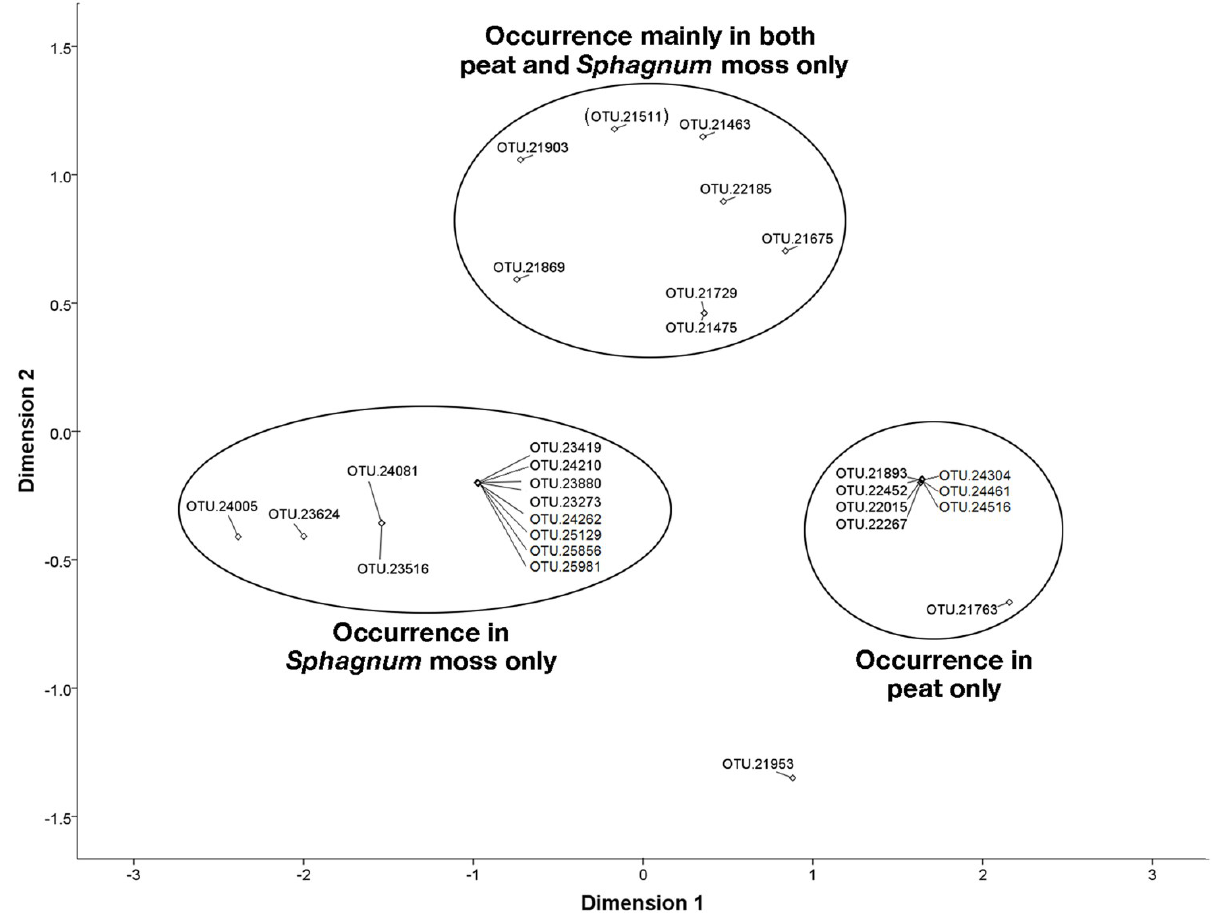
Figure 6. Similarity in the presence and abundance of the Methylococcaceae detected in peat, forest soil, and Sphagnum moss as a two-dimensional plot of nonmetric multidimensional scaling (NMDS; Stress = 0.07667, R 2 = 0.97896). OTUs on the NMDS plot that are closer to one another are more similar in their occurrence. The OTUs from the Methylococcaceae occurring in peat only, Sphagnum moss only and mainly in peat and Sphagnum moss only, with the exception of OTU 21511 (in parenthesis), which also occurred in forest soil, in addition to peat, and Sphagnum moss, appear to be more similar to one